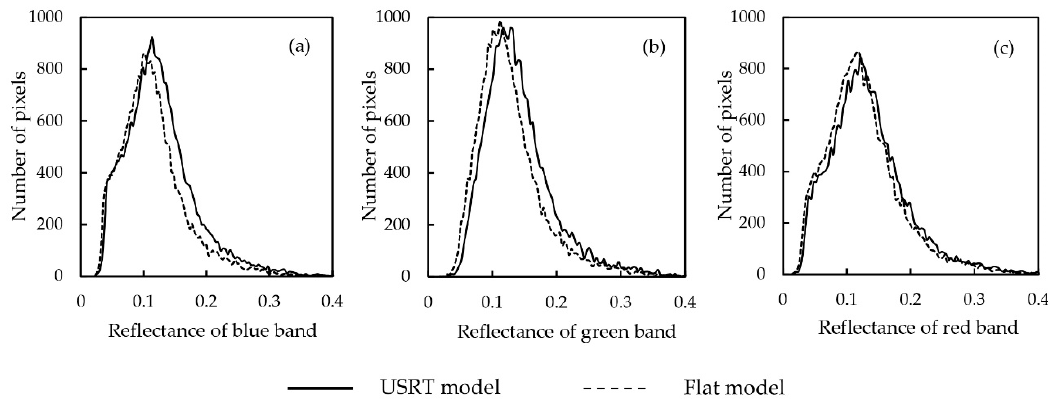
Figure 7. Urban 3D surface reflectance derived from the USRT model and the flat model: ( a ) reflectance graph of the blue band; ( b ) reflectance graph of the green band; ( c ) reflectance graph of the red band.